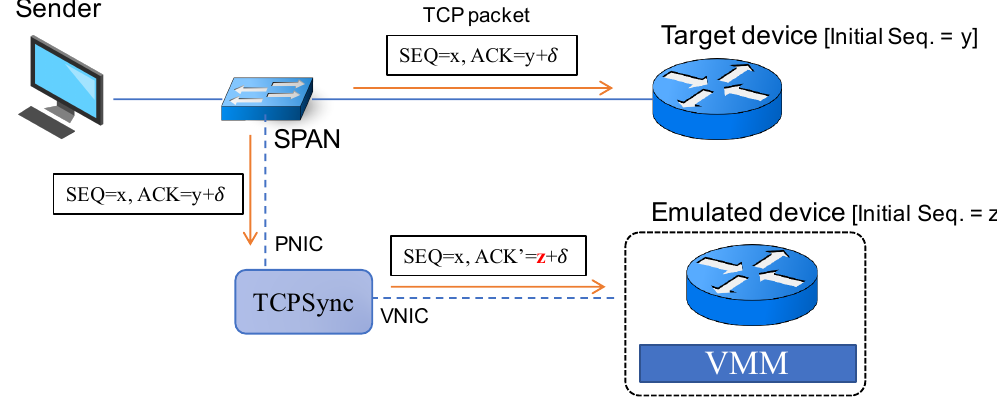
Figure 3. Transparent conversion of TCP packets by TCPSync ( x , y , z are initial sequence numbers of a sender, target device, and emulated device,